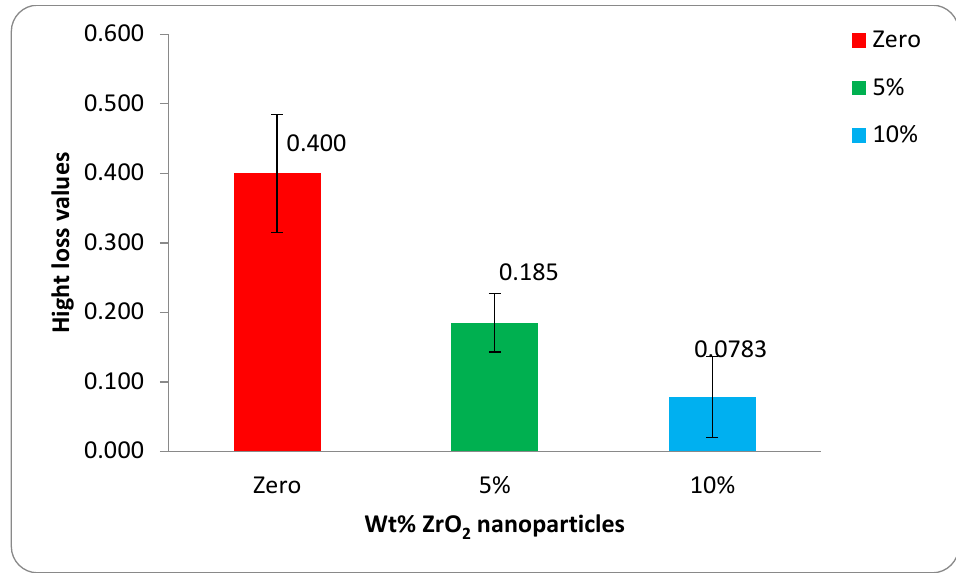
Figure 10. Mean height loss of the tested groups after wear testing.